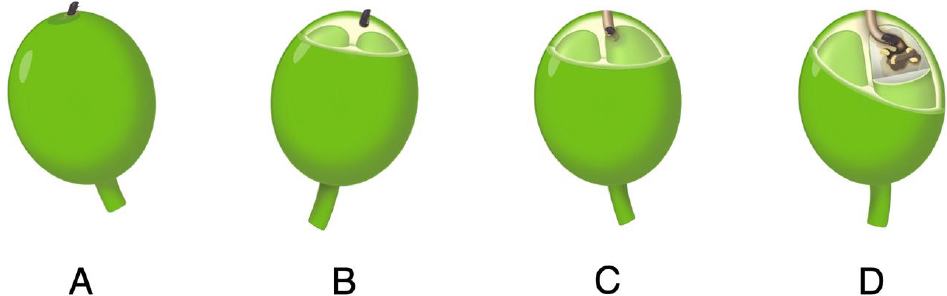
Figure 1. Positioning of the coffee berry borer (CBB) on or in the coffee berry [3]. Position ( A )—the adult beetle has landed on the berry and initiated a tunneling site. Position ( B )—the beetle has entered the epidermis of the berry but has not yet infested the bean. Position ( C )—the beetle has penetrated the parchment and infiltrated the coffee bean. Position ( D )—the adult beetle has laid eggs and the resulting larvae feed on the endosperm.